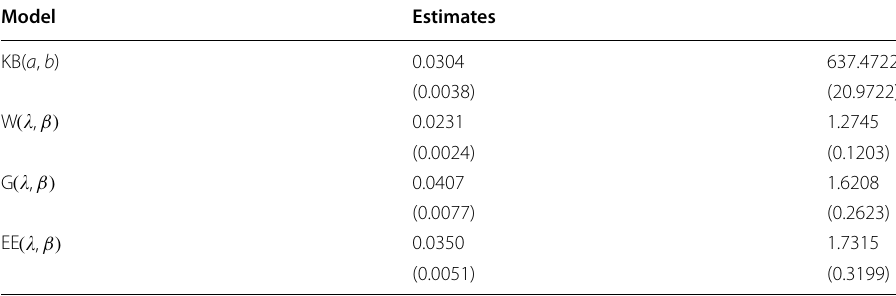
Table 5 MLEs and SEs for dataset 2 Model